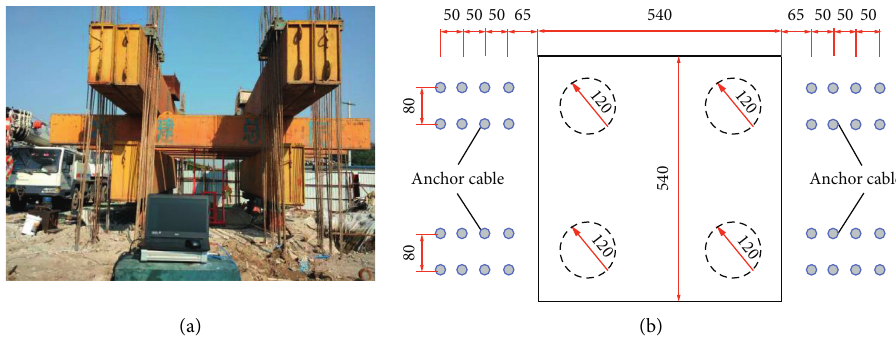
Figure 12: The loading test equipment (a) and the arrangement of anchor bolts around the cap (unit: cm) (b).